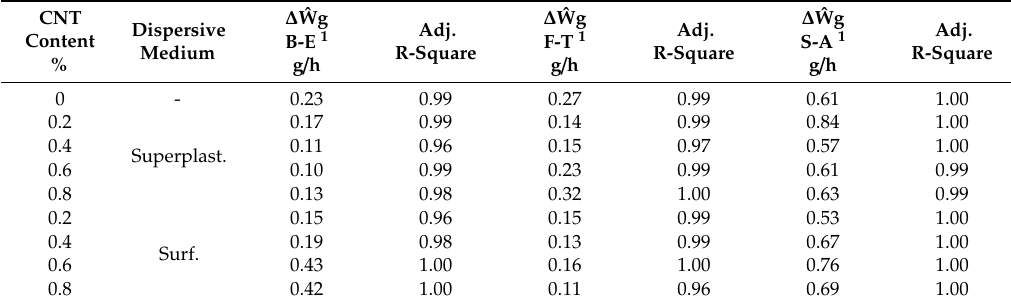
Table 3. Mass flow rate of methanol, ∆ ˆWg as a function of CNT content, dispersive medium and exposure